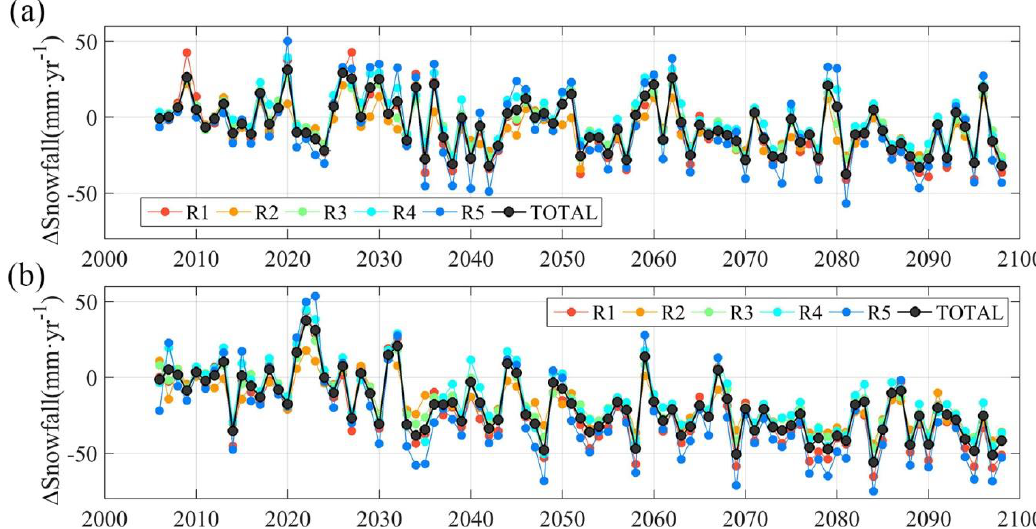
Figure 7. Annual evolution of the annual snowfall anomalies during the future study period of 2000– 2100 for ( a ) RCP 4.5 and ( b ) RCP 8.5, averaged over each region in Sierra Nevada (Figure 1) and the whole study area.